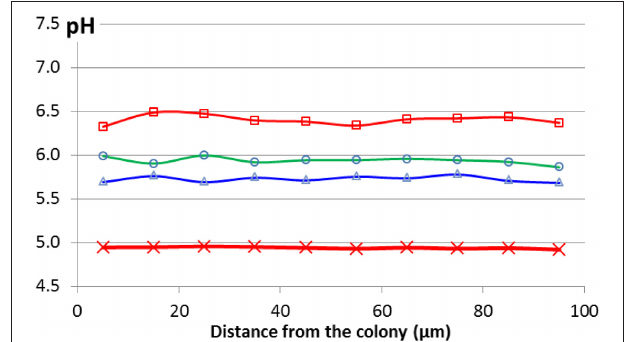
FIGURE 6 | pH profile through a 2-day old colony of Salmonella Typhimurium, inoculum density 1cell/ml, initial pH 7.0, glucose at 1% (w/v). Solid squares indicate points where actual measurements were taken. Solid lines indicate pH isopleths which represent an approximation of where the pH gradients may lie. The green area shows colony location. Adapted from Walker et al. (1997).